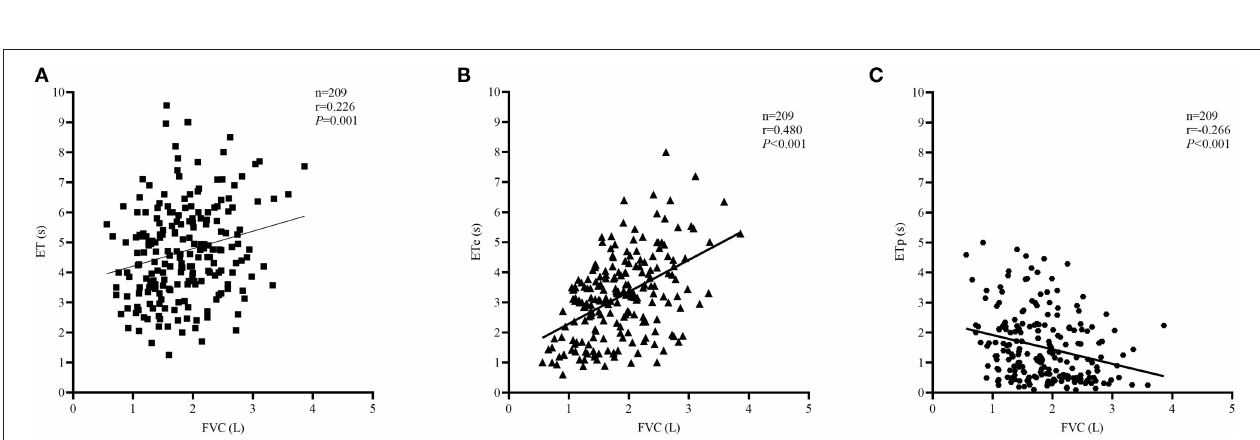
FIGURE 2 | Correlations between ET, ETe, ETp, and FVC in the whole subjects. The correlation coefficients were obtained by Pearson’s correlation. (A) Changes in ET related to FVC values. (B) Changes in ETe related to FVC values. (C) Changes in ETp related to FVC values.